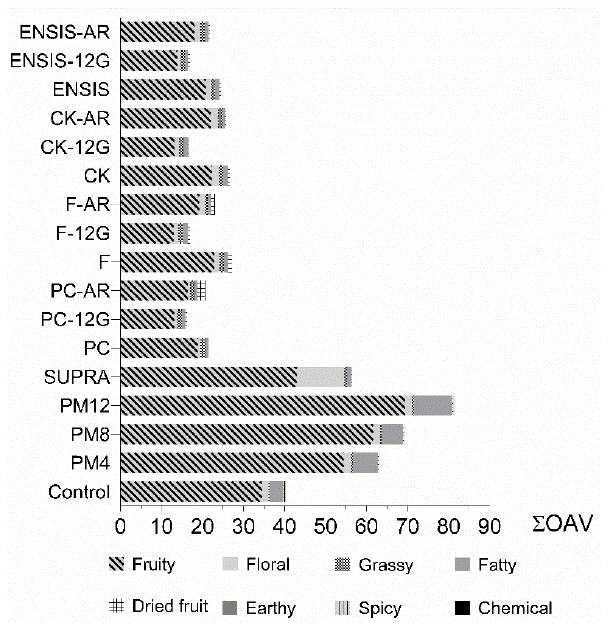
Figure 2. Summary of odour activity values ( Σ OAV) by odorant series. PM4, PM8